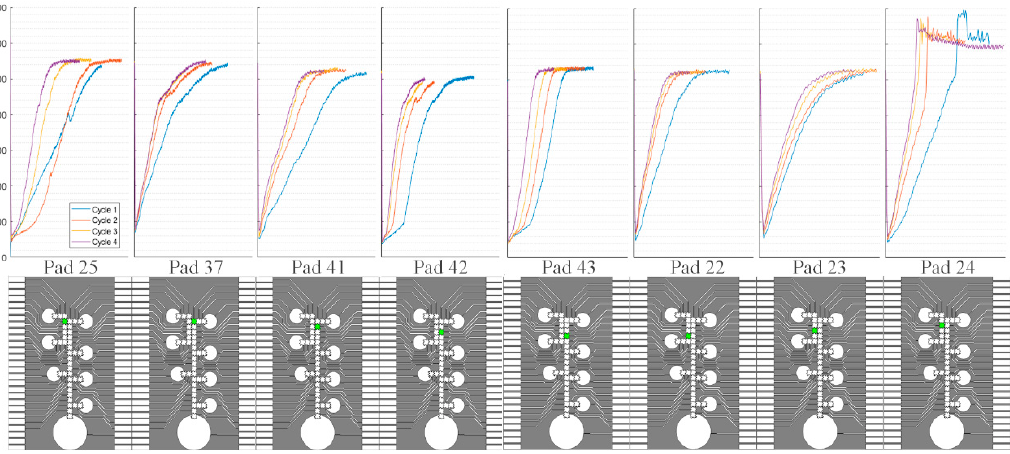
Figure 16. Position feedback V sense plots.